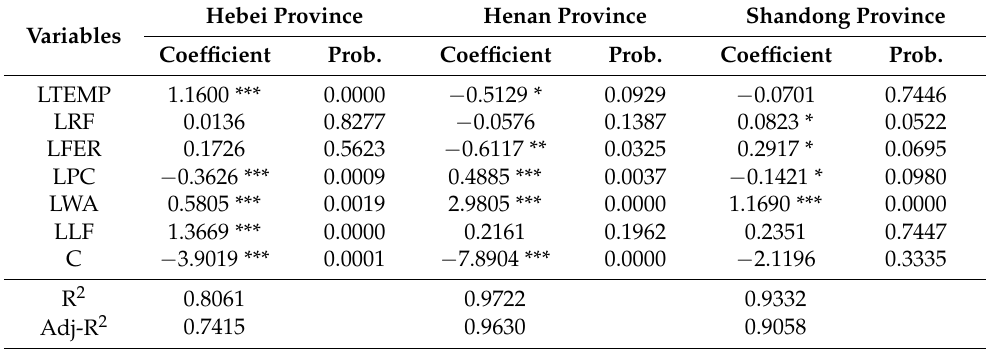
Table 4. Results of FMOLS estimator for top three provinces in northern China. Hebei Province Henan Province Shandong Province Variables Coefficient Prob. Coefficient Prob. Coefficient